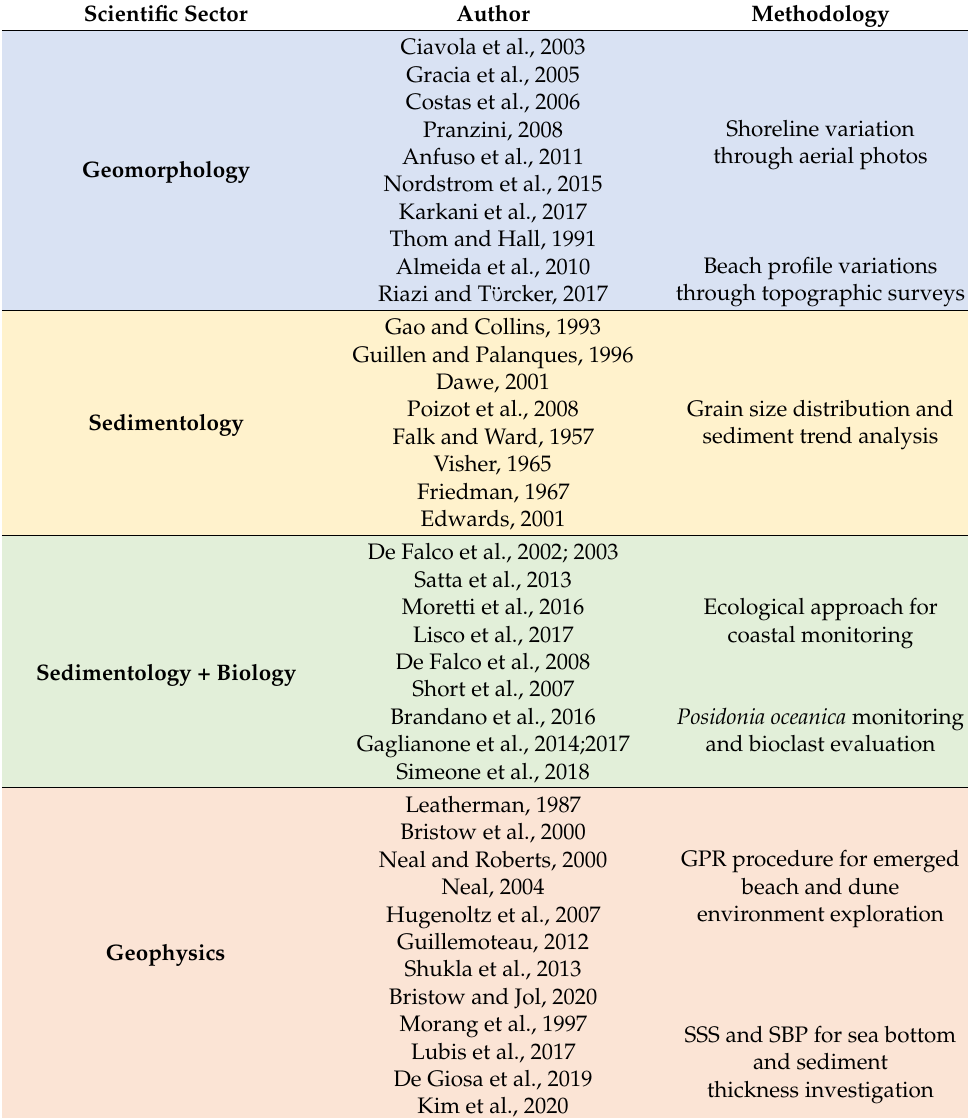
Table 1. Techniques for beach monitoring applied in the different sectors of the Earth Sciences. Each color represents a scientific sector with the relative authors. GPR: Ground Penetrating Radar, SSS: Side Scan Sonar; SBP: Sub Bottom Profiler. Geomorphology [44–53]; Sedimentology [54–61]; Sedimentology + Biology [17,27,62–70]; Geophysics